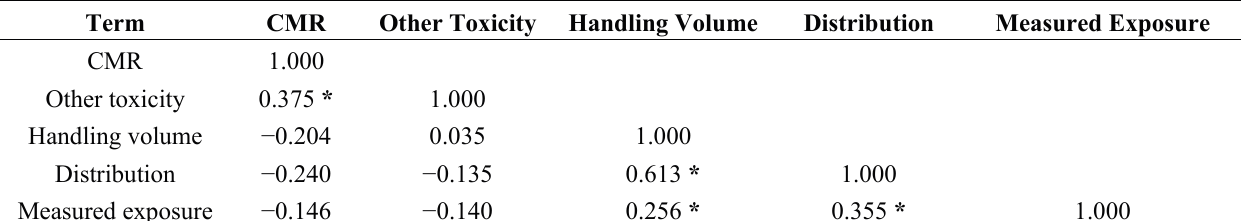
Table 7. Correlation coefficients (r) from the linear regression analysis for individual indicator